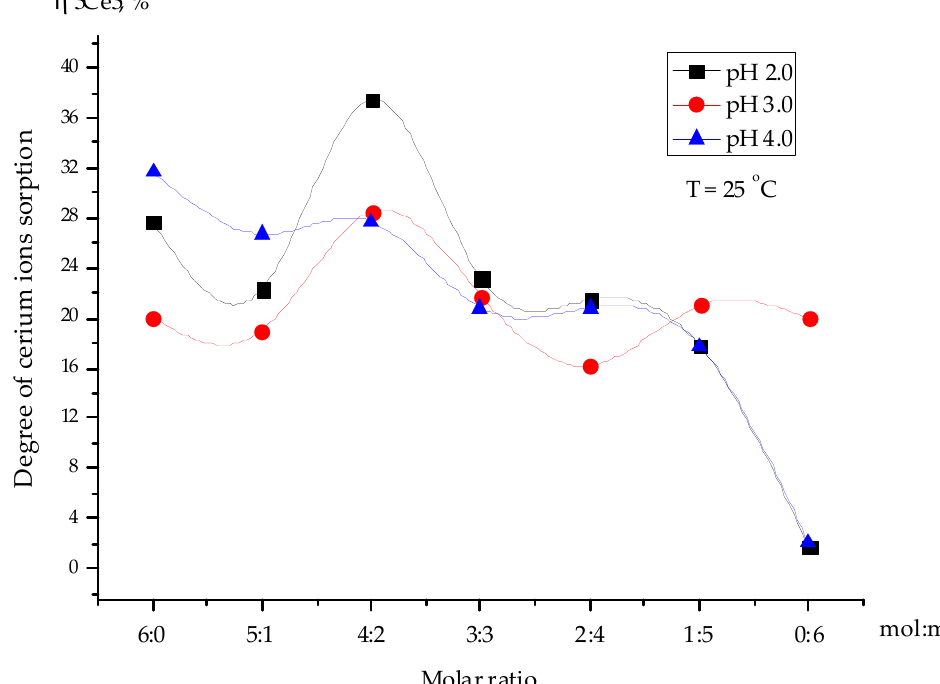
Figure 3. Dependence of cerium ion sorption extraction by the interpolymer system “Amberlite IR120:AV-17-8” (X:Y) (6:0, 5:1, 4:2, 3:3, 2:4, 1:5, and 0:6) on the pH of the solution as a function of the molar ratio X:Y after 48 h.